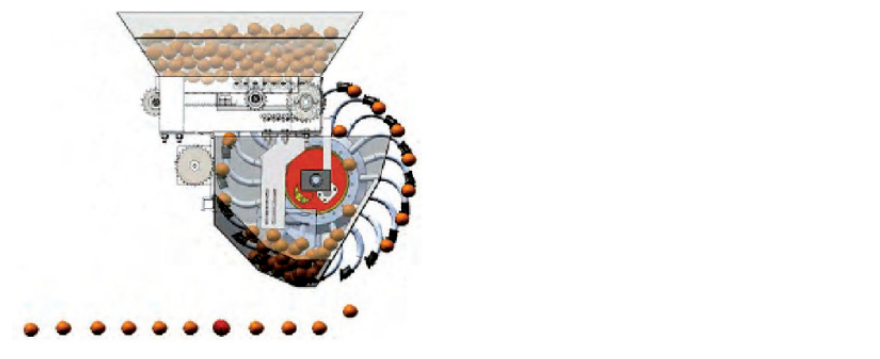
Figure 24. The intelligent seed supply system of the air-suction potato planter. Reprinted with permission from ref. [18] Copyright 2022 Northeast Agricultural University.